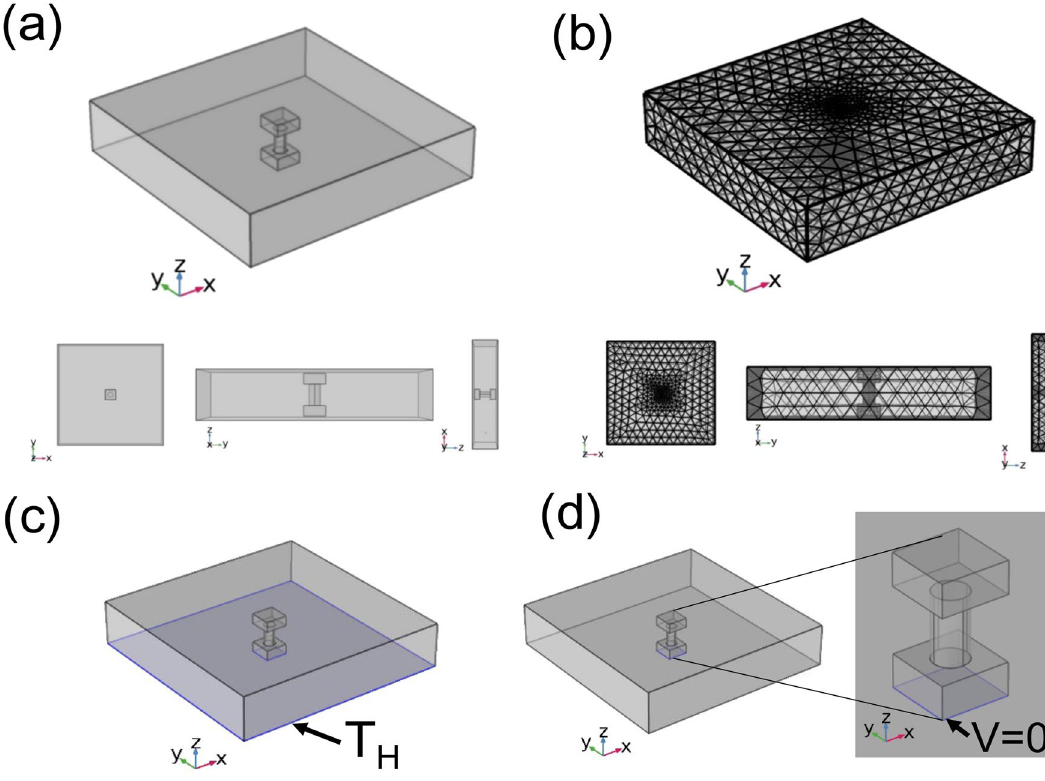
Figure 5. Computation model of the TEG module and the I-layer brick type of thermoelectric concrete brick using COMSOL Multiphysics v.5.5 software (https:// www. comsol. com) 40 : ( a ) Schematic diagram of the geometry model, ( b ) finite element mesh of the simulation model, and boundary condition of the model of the simulation model, ( c ) constant hotter temperature and ( d ) electric potential boundary condition at the hotter side of the TEG module and thermoelectric